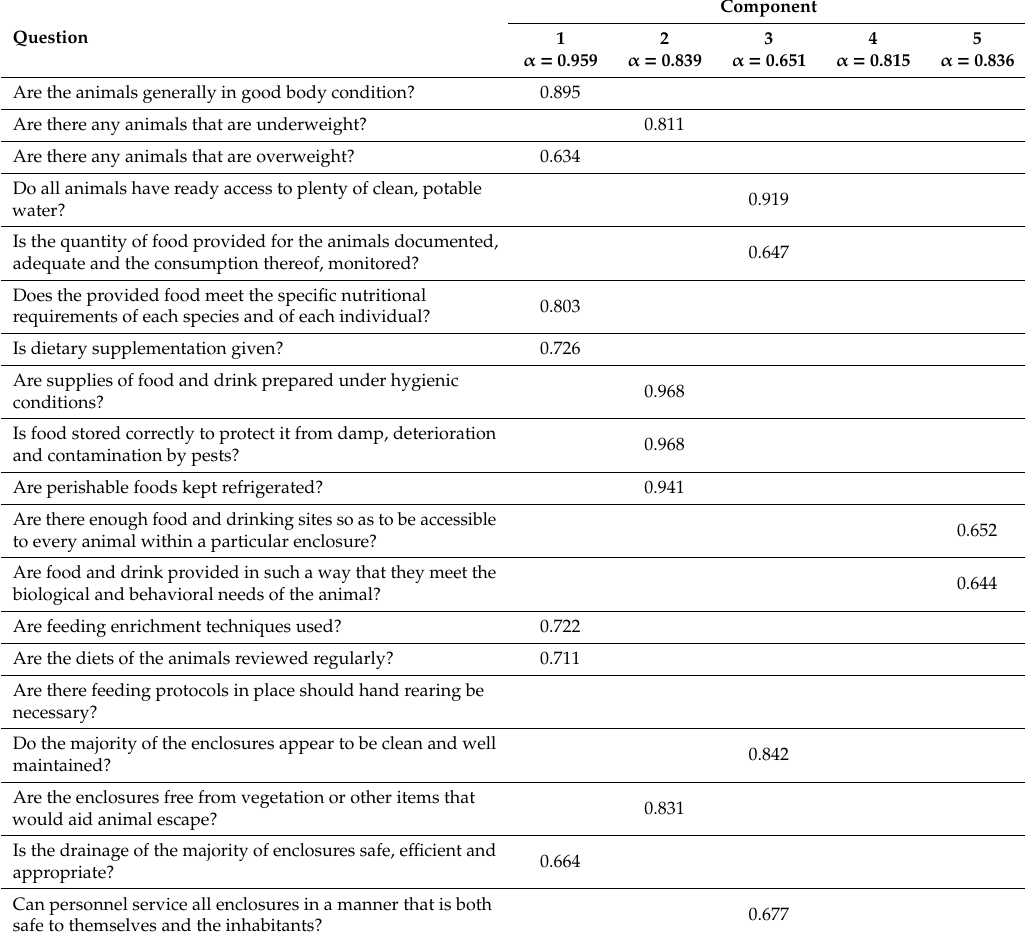
Table 1. Results of principal component analysis from the Wild Welfare